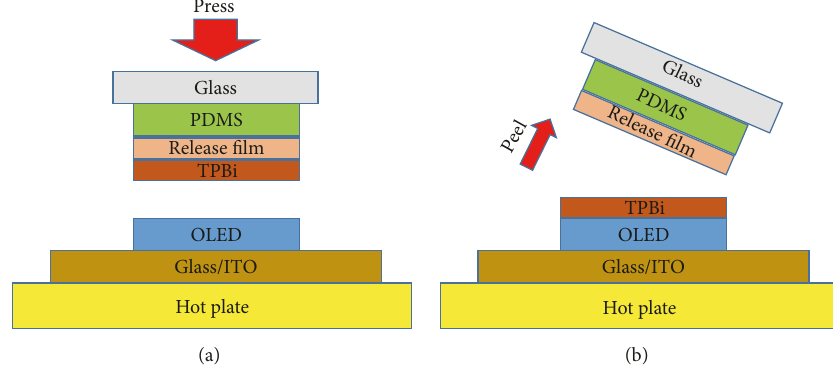
Figure 1: Schematic illustration of release film stamping processes: (a) pressing stamp and (b) peeling